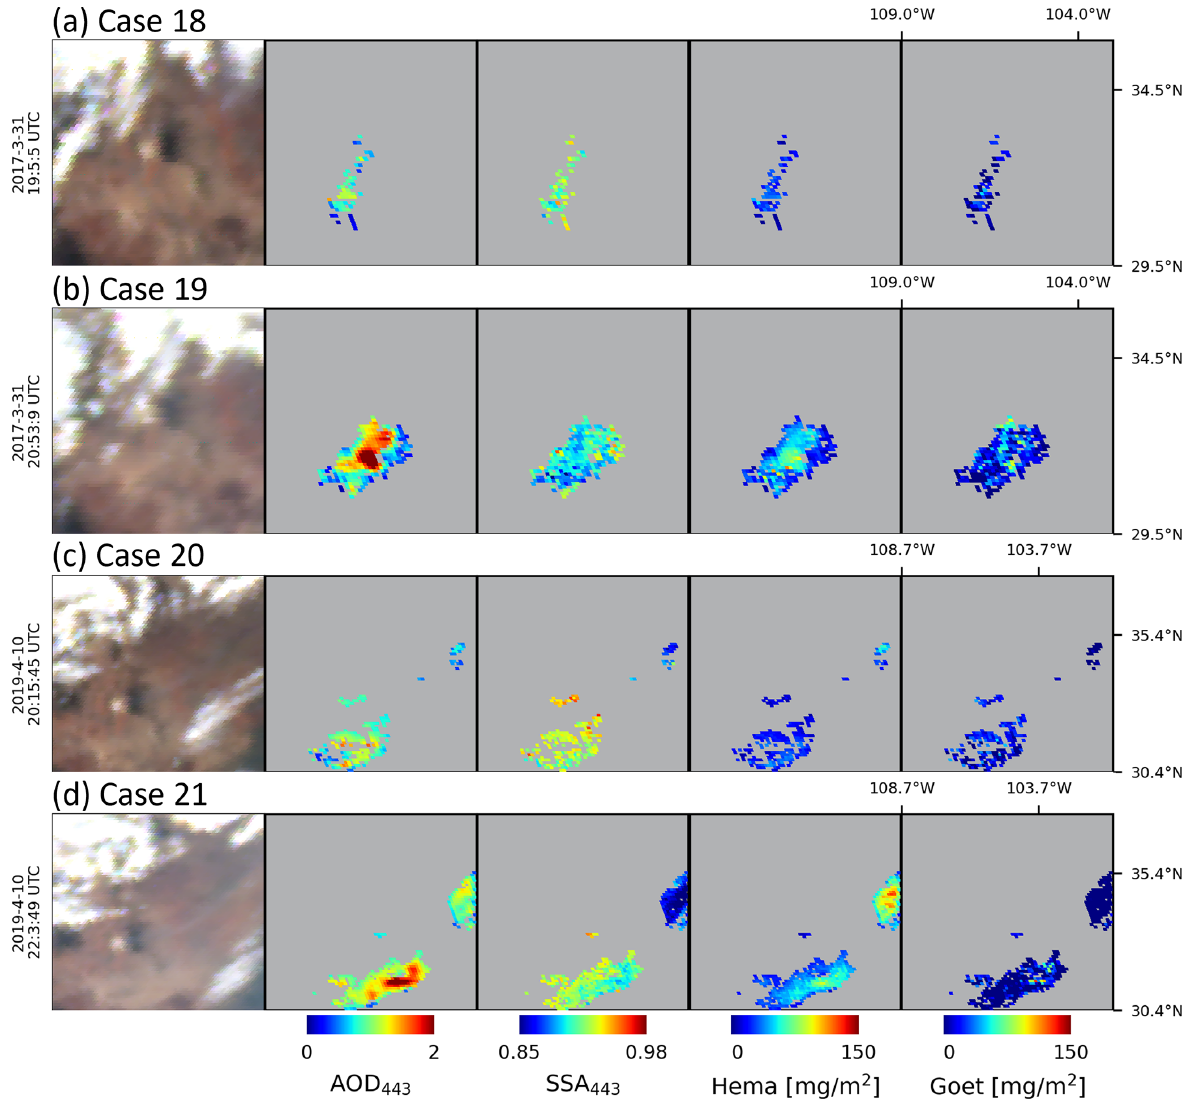
Figure A5. Dust episodes over North America near New Mexico, USA. From left, RGB TOA image generated from EPIC L1B version 3 data, AOD 443nm, SSA 443nm, hematite mass concentration, and goethite mass concentration for each case: case 18 (row 1), dust episode on 31 March 2017, 19:00UTC; case 19 (row 2), dust episode on 31 March 2017, 20:00UTC; case 20 (row 3), dust episode on 10 April 2019, 20:00UTC; and case 21 (row 4), dust episode on 10 April 2019, 22:00UTC.